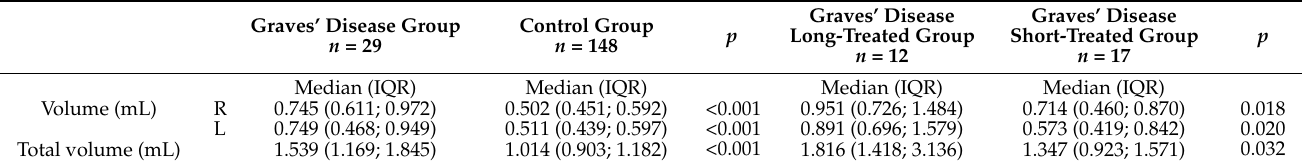
Table 2. Thyroid parameters between